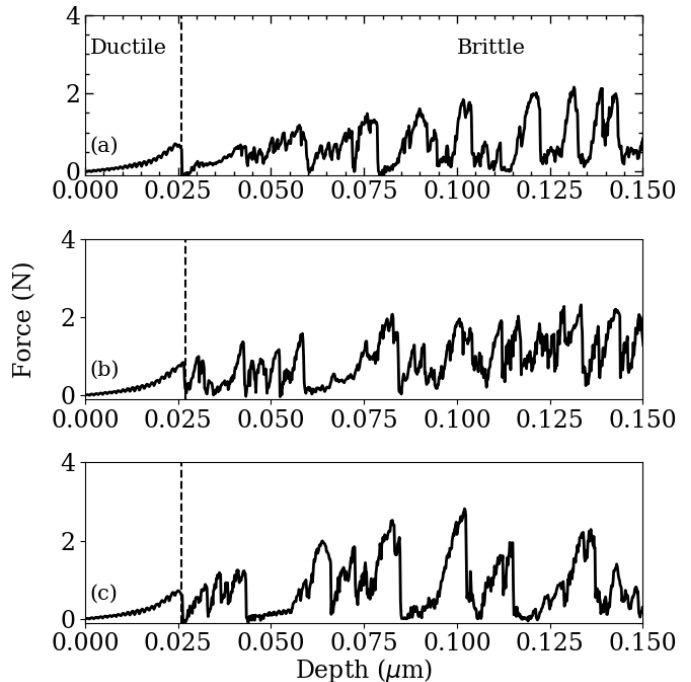
Figure 7. Grooving force vs. depth of cut for rake angles of − 15 ◦ ( a ), − 22.5 ◦ ( b ) and − 30 ◦ ( c ). The vertical dashed lines denote the transition depth that separates the ductile and the brittle regimes, respectively. In the ductile regime, the cutting force increases smoothly with the depth of cut, whereas the brittle regime is characterized by large oscillations of the